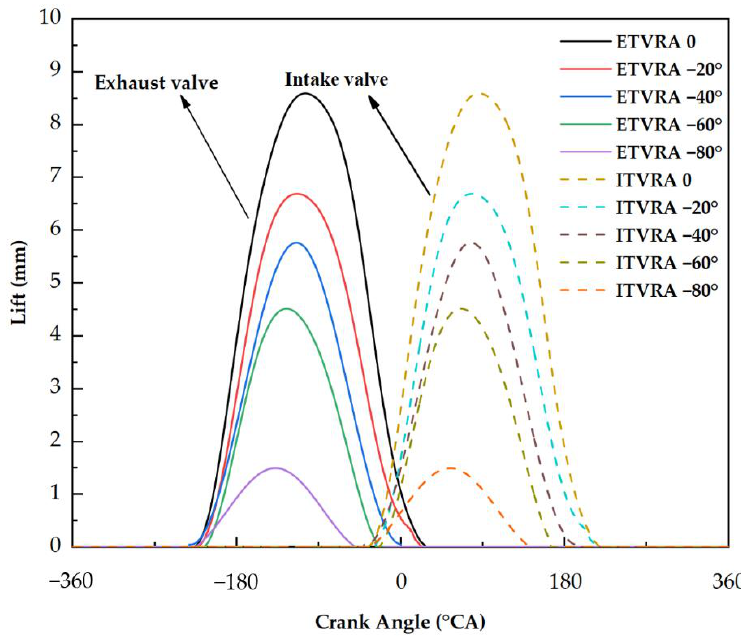
Figure 2. Engine valves lift curves (negative sign indicates counterclockwise rotation).